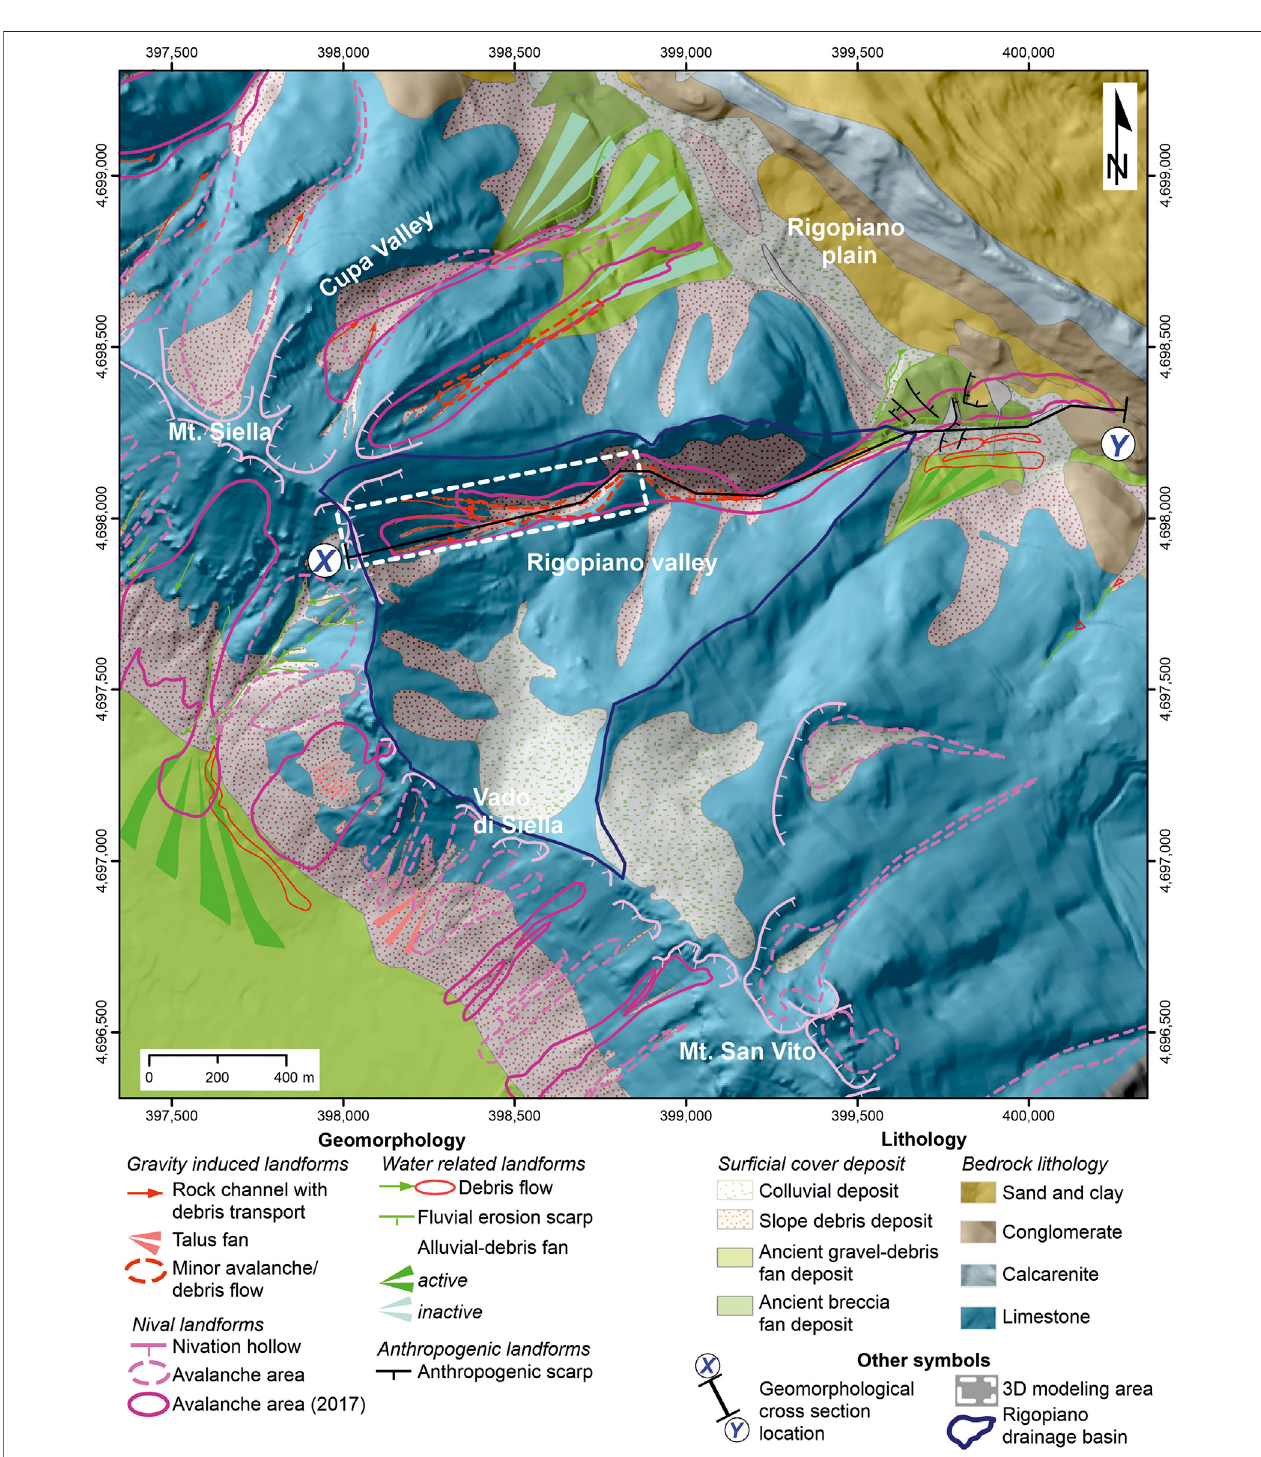
FIGURE10| GeomorphologicalschemeoftheRigopianoarea.Theschemeoutlinesthescatteredsuper fi cialdepositscoveringtheeastslopeofMt.Siella – Vadodi Siella and the mostly exposed bedrock. The main nival (pink), gravity-induced (red), and water-related landforms (green) are mapped.